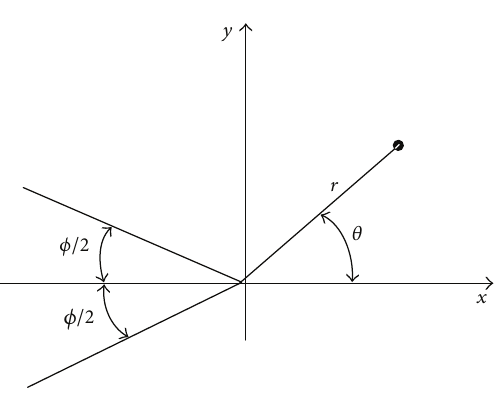
Figure 6: Calculating model of V-shaped